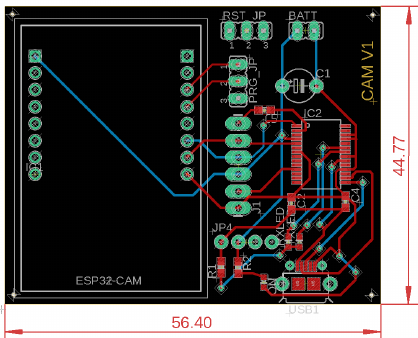
Figure 8. Designed camera node PCB board for ESP32-CAM breakout.